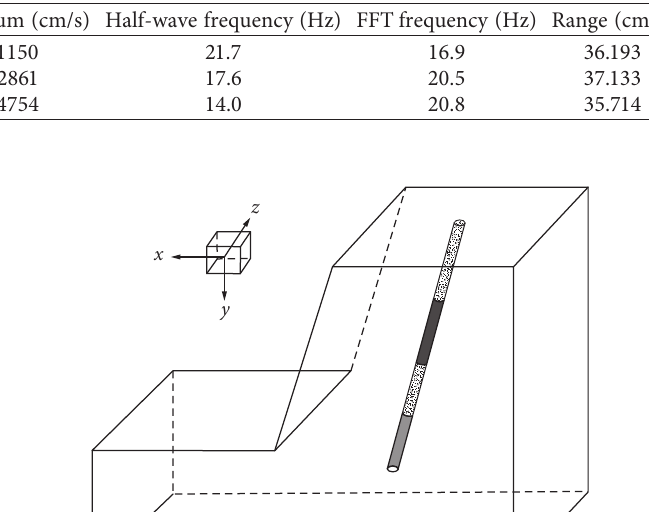
Figure 5: Vibration velocity of the monitoring point by the field test. (a) X -direction vibration of the monitoring point by the field test. (b) Y -direction vibration of the monitoring point by the field test. (c) Z -direction vibration of the monitoring point by the field Table 2: Measured vibration-related data.